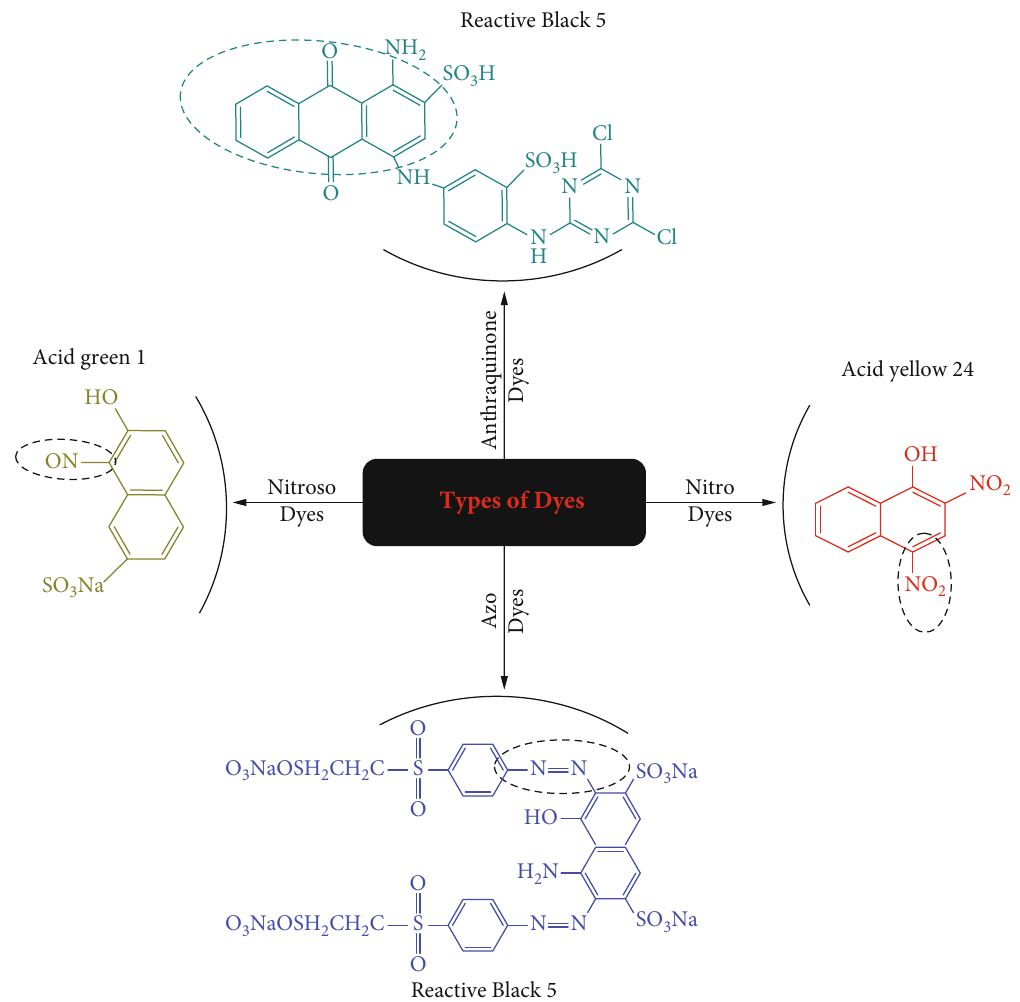
Figure 6: Classi fi cation of dyes based on the chemical